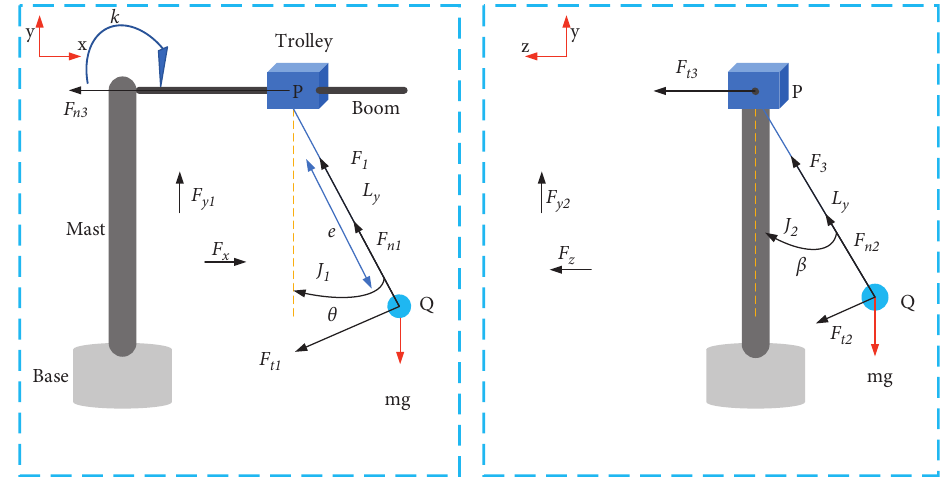
Figure 2: Force analysis of